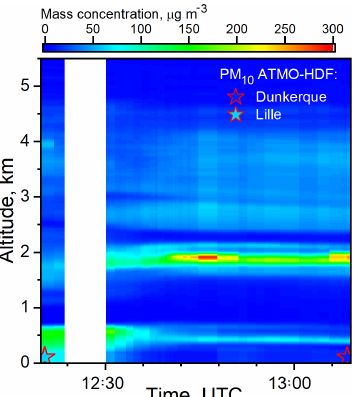
Figure 11. Spatio-temporal variability of lidar–sun-photometer- derived mass concentration (colour map) from on-road measure- ments along Lille–Dunkerque transect on 26 August 2016 (12:18– 13:10UTC). The PM 10 mass concentrations from closest mea- surements from air quality stations along the route are overlapped (colour mapped